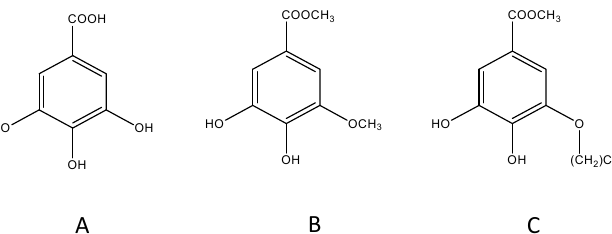
Figure 1. Chemical structure of gallic acid ( A ); methyl-3- O -methylgallate ( B ); and propyl-3- O -methylgallate ( C )